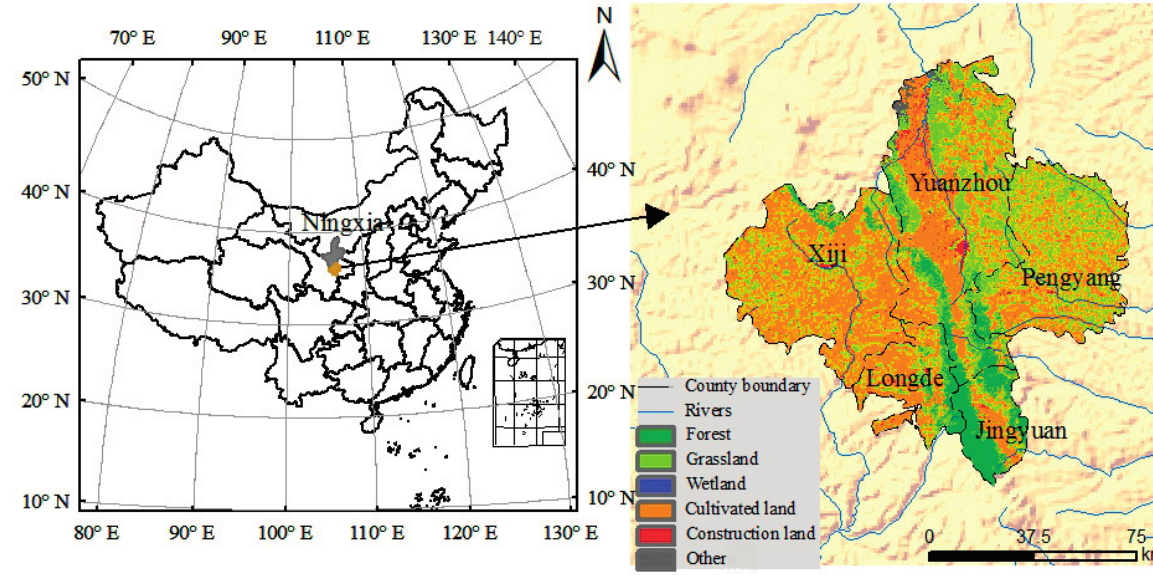
Figure 1. The location and land-use map of